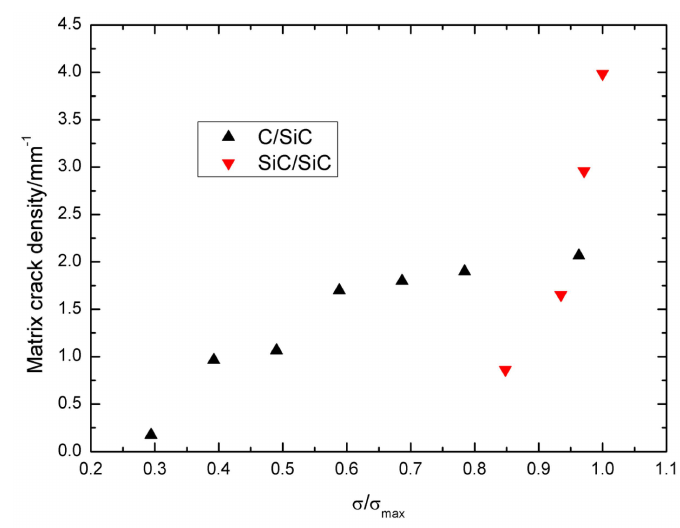
Figure 11. The matrix crack density of matrix cracking mode 3 in the 0 ˝ plies vs. normalized stress σ / σ max of cross-ply C/SiC and SiC/SiC